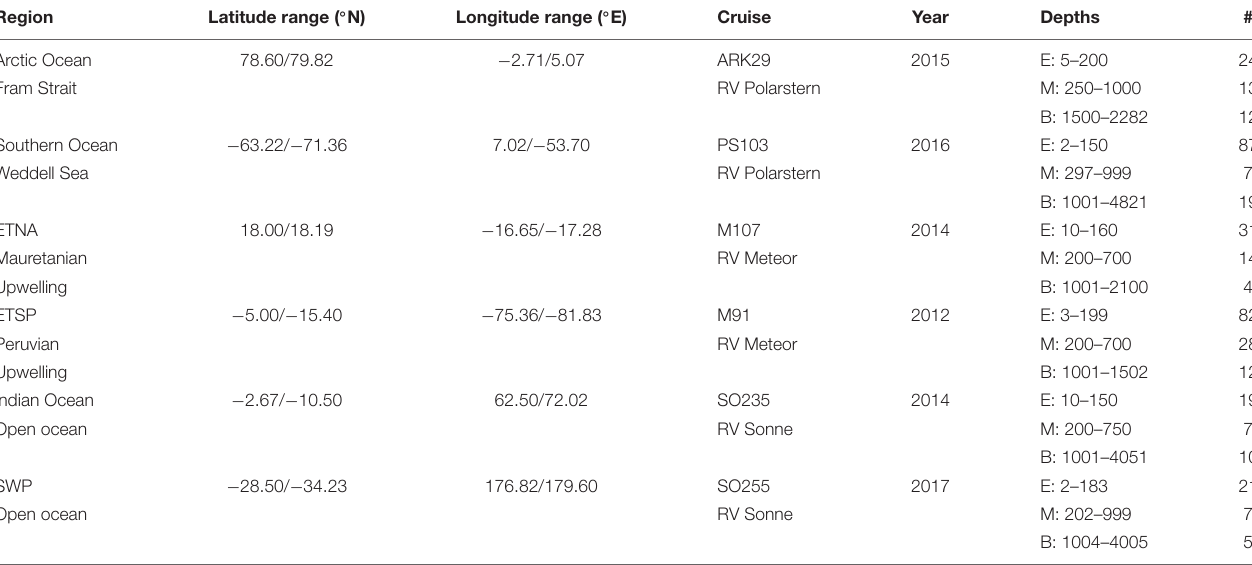
TABLE 1 | Cruise and sampling information for gel particles.